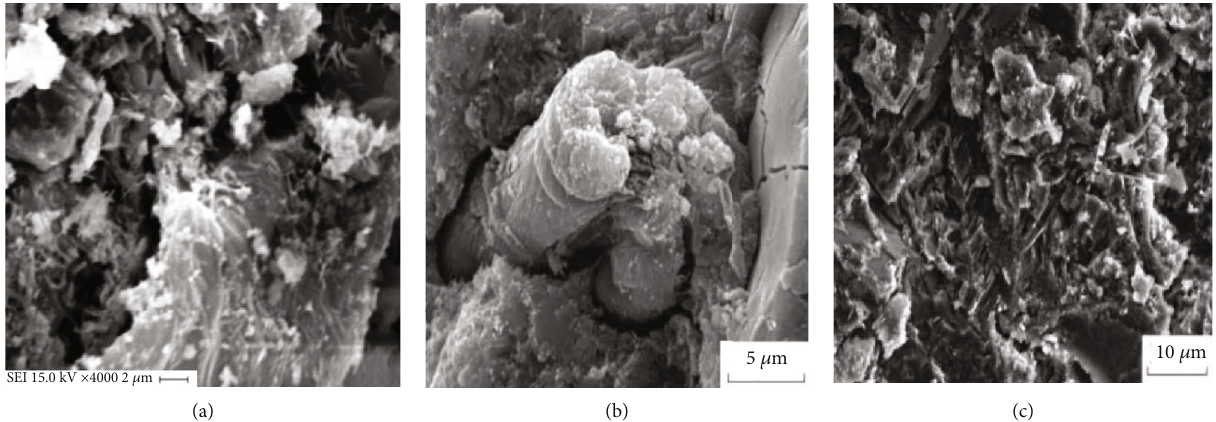
Figure 4: (a) Microstructure [72]. (b) Voids around the CFs. (c) Micro-nano-level microcrystalline cellulose